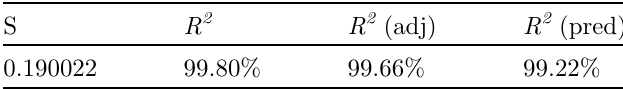
Table 7. Coded coef fi cients.